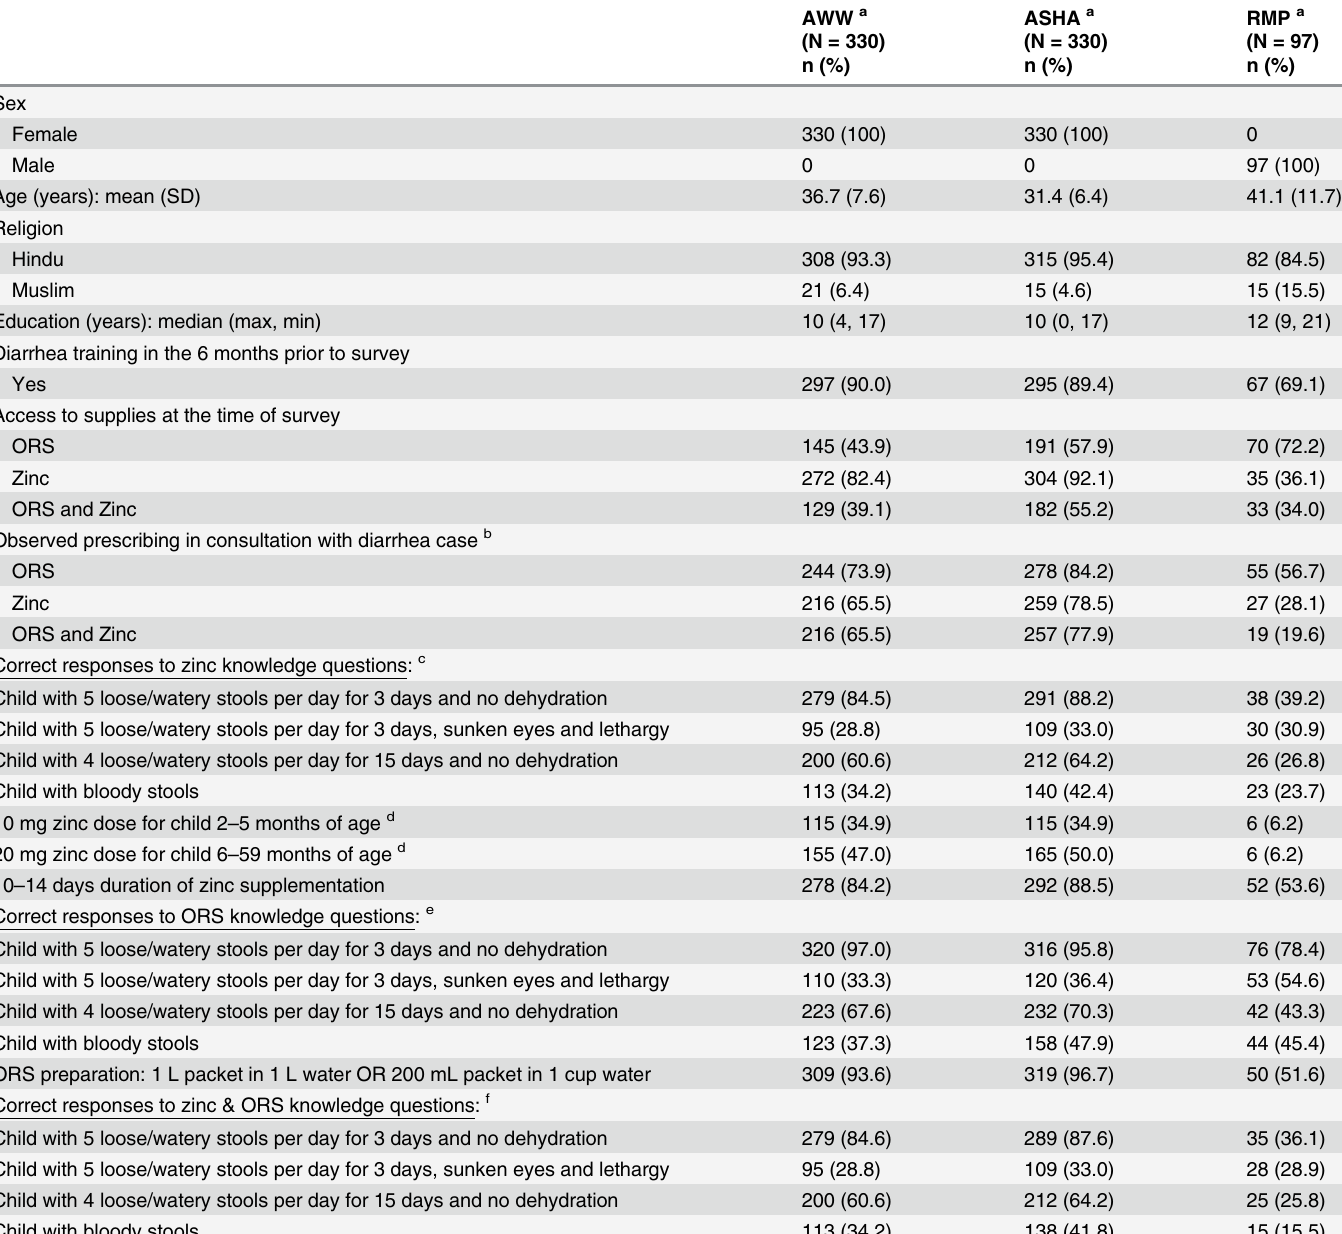
Table 2. Reported and observed characteristics of AWWs, ASHAs and